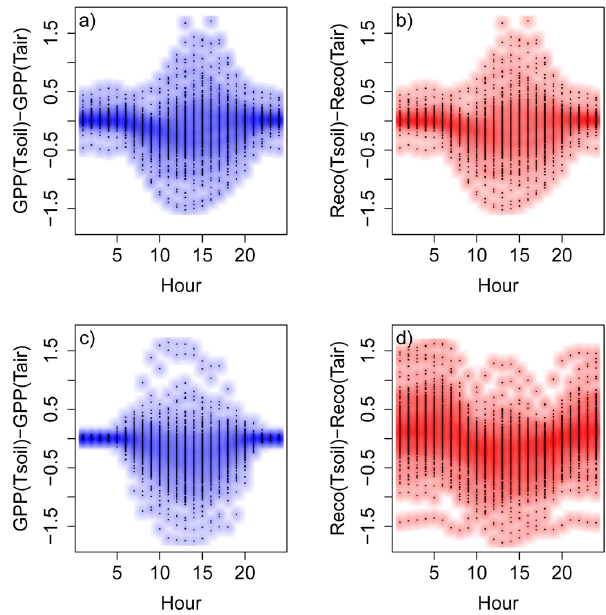
Fig. 9. Mean diurnal cycle of differences [µmolCm − 2 s − 1 ] be- tween the estimates using soil and air temperature, averaged over the growing season for the Reichstein et al. (2005) (a) , (b) and for the Lasslop et al. (2010) approach (c) , (d)